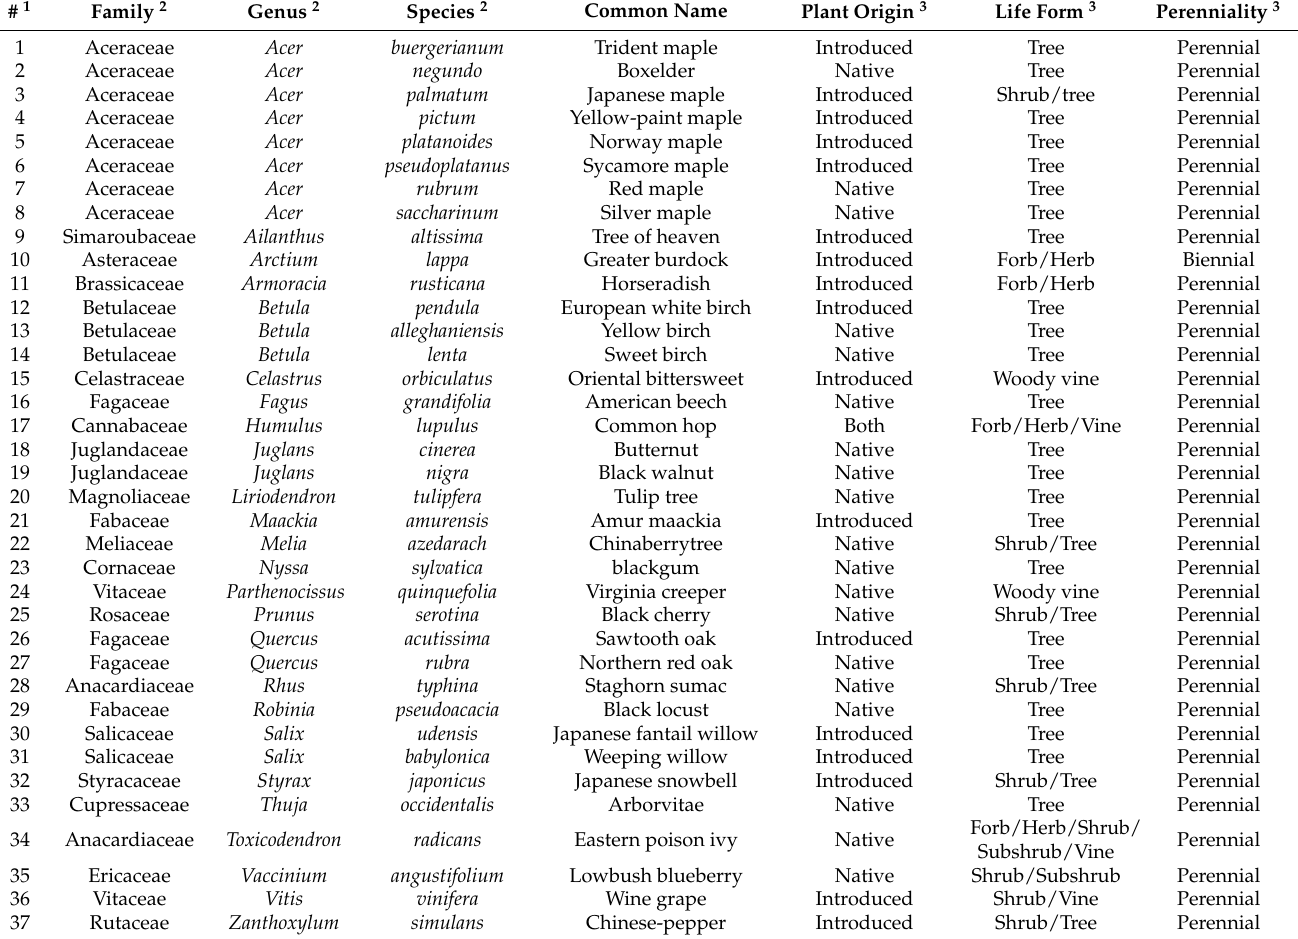
Table 2. Host plants of Lycorma delicatula in the introduced range in the US, and their plant